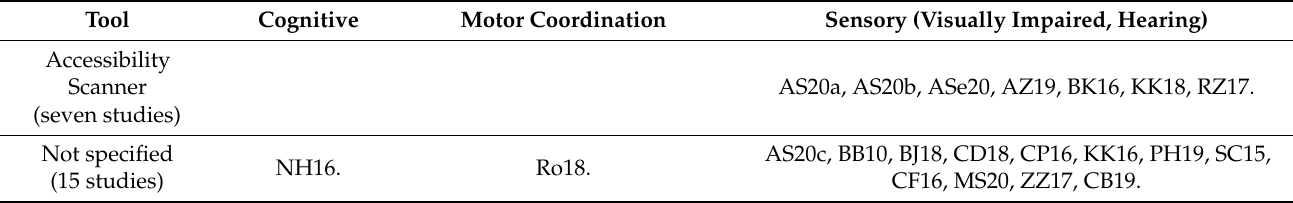
Table 9. Documents according to the tool used to evaluate accessibility in mobile applications.